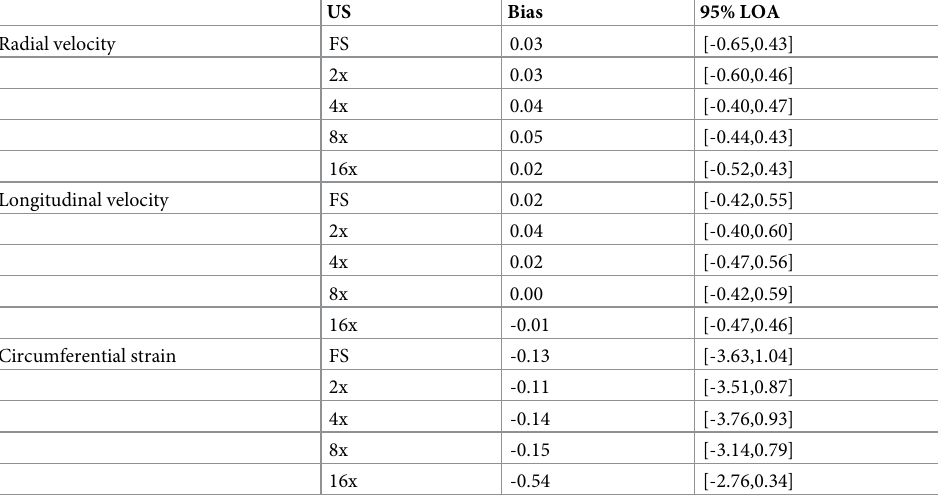
Table 3. Intrastudy